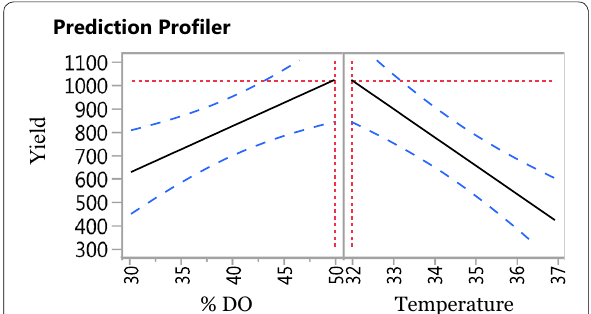
Fig. 2 Prediction profiler from DOE optimization study evaluating three process parameters indicating reduction in growth temperature to 32 °C along with increasing the percent DO improve product